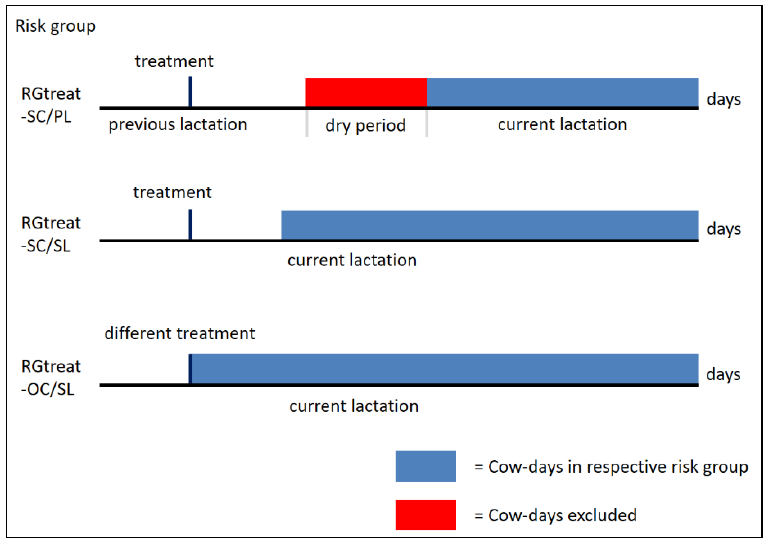
Figure 2. Schematic representation of the assignment of the cow-days to one of the three risk groups: (RGtreat-SC/PL (at least one treatment of the same category in the previous lactation), RGtreat-SC/SL (at least one previous treatment of the same category in the same lactation) and RGtreat-OC/SL (at least one previous treatment of another category in the same lactation).